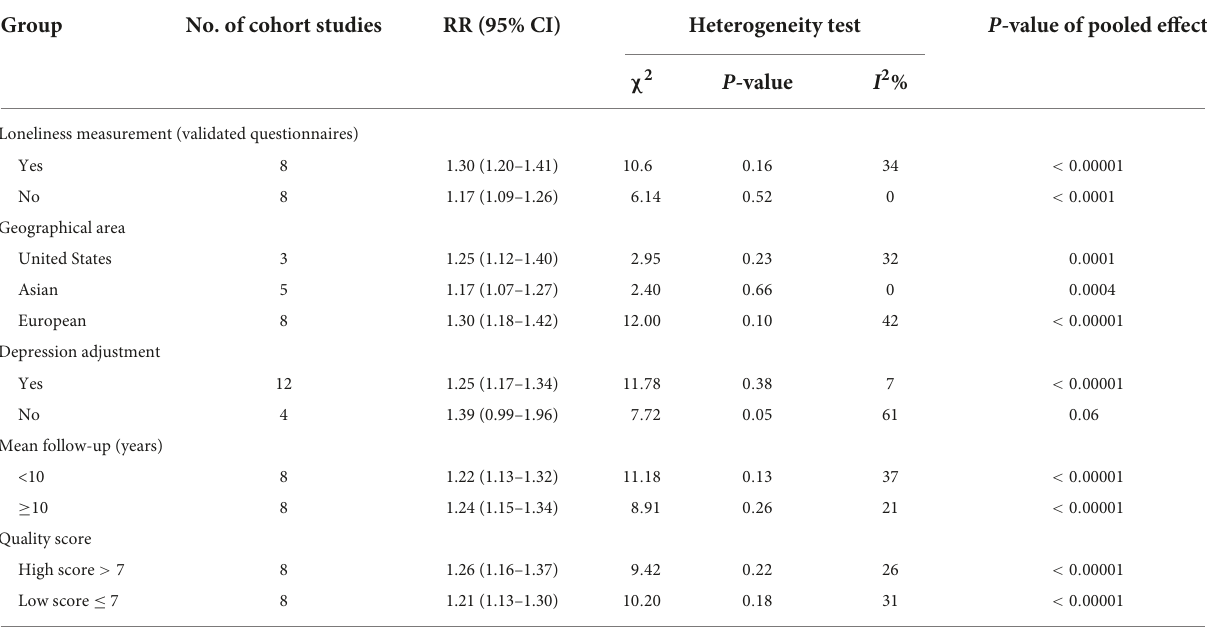
TABLE 1 Stratified analyses of loneliness and dementia